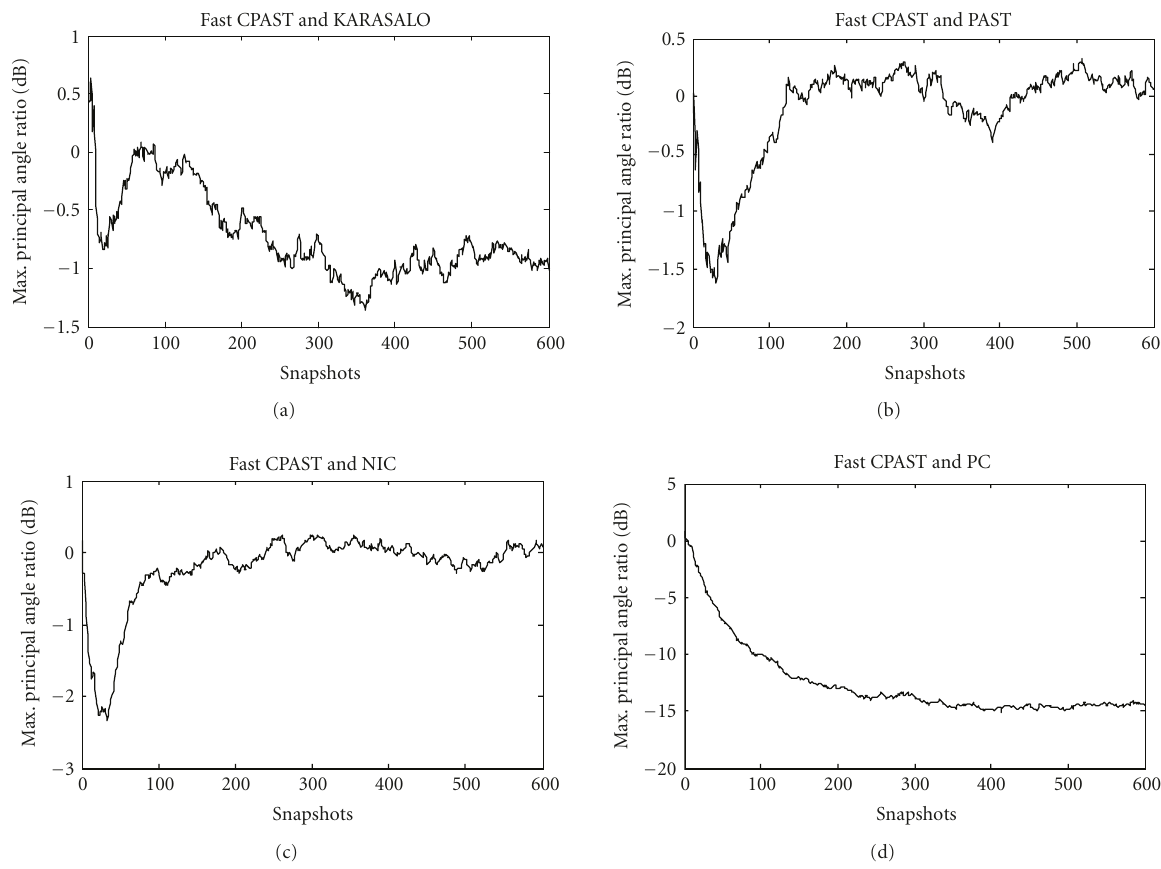
Figure 6: Ratio of maximum principal angles of fast CPAST and several other algorithms in the third simulation scenario.